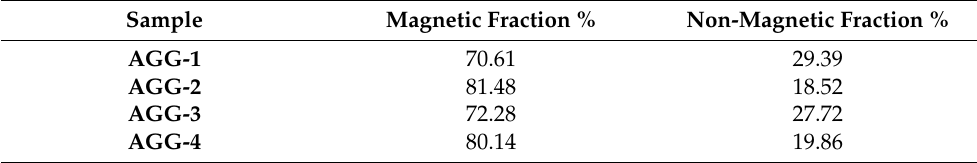
Table 2. Magnetite w.t.% and magnetic and non-magnetic fractions of the whole